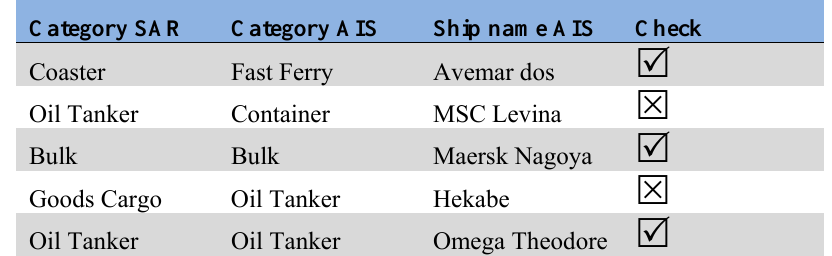
Table 2. SAR-AIS category cross-correlation for detections performed in an ENVISAT image. Category